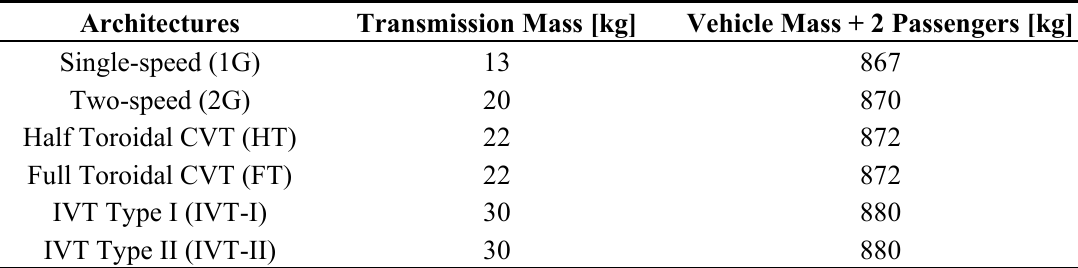
Table 2. Transmission and vehicle